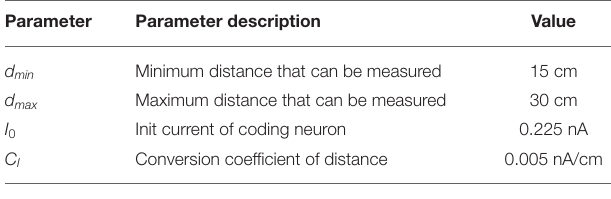
TABLE 2 | The parameters used in the data